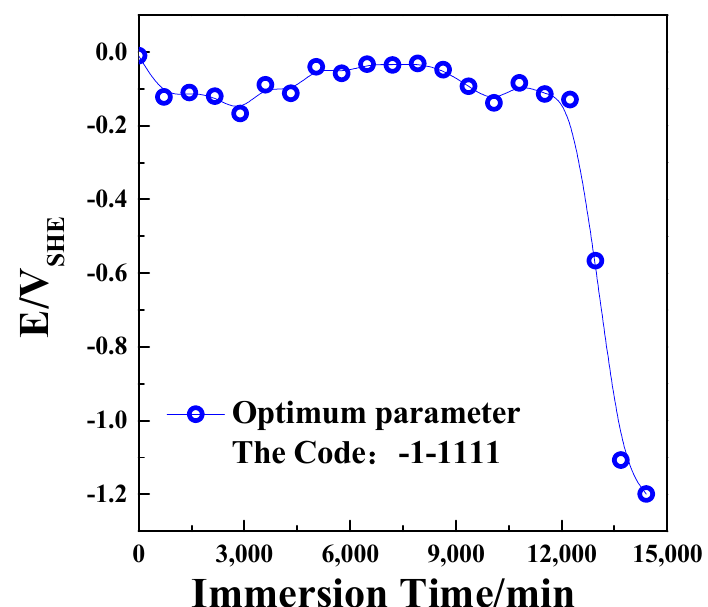
Figure 3. Immersion test result for Ni–W–P alloy coating under optimal process